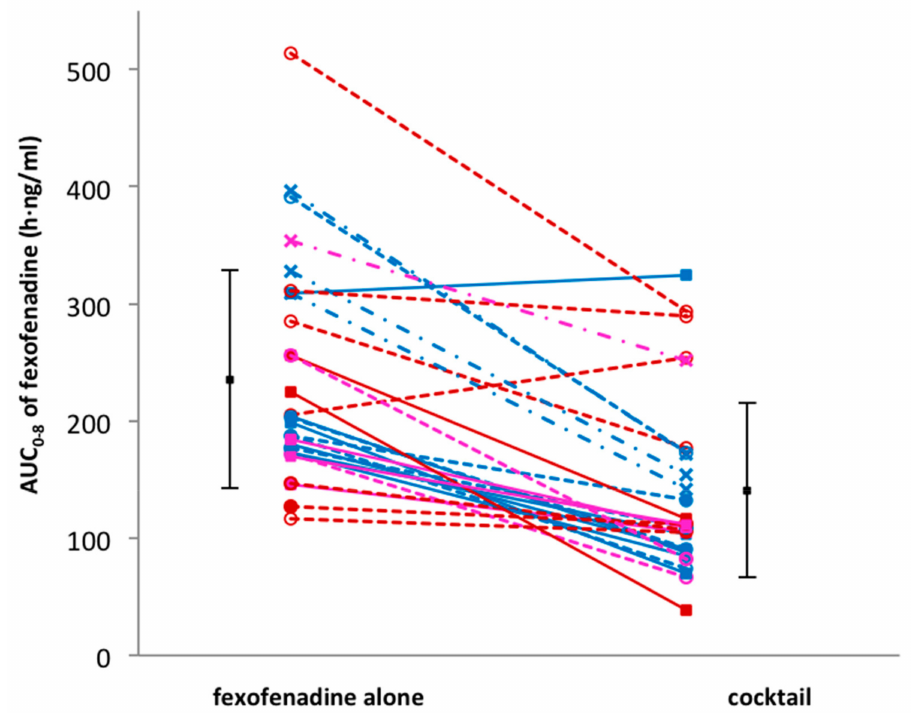
Figure 2. Comparison of individual fexofenadine AUC after administration of fexofenadine alone versus fexofenadine in cocktail. Volunteers in genotype group (a) are shown as solid lines and full squares; genotype group (b) as dotted lines and open symbols; genotype group (c) as dashed lines and cross